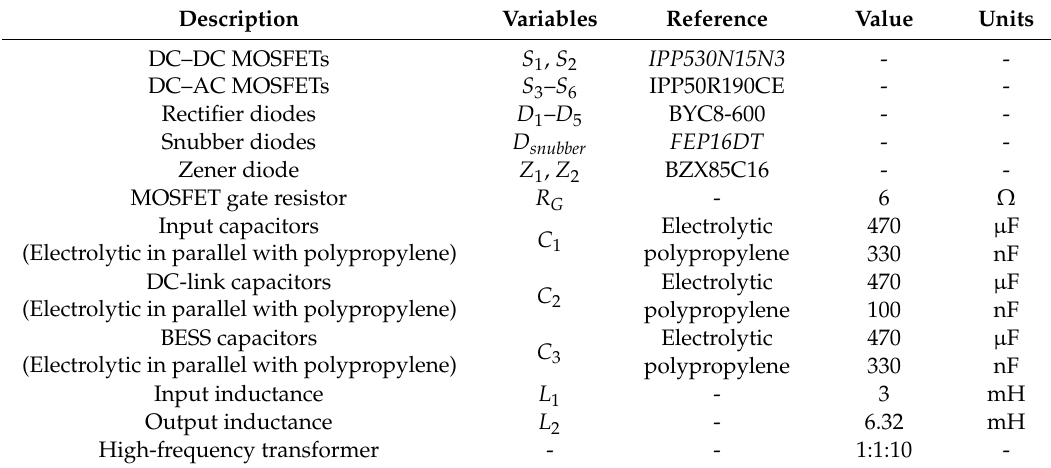
Table 5. List of the main components used in the multifunctional isolated microinverter